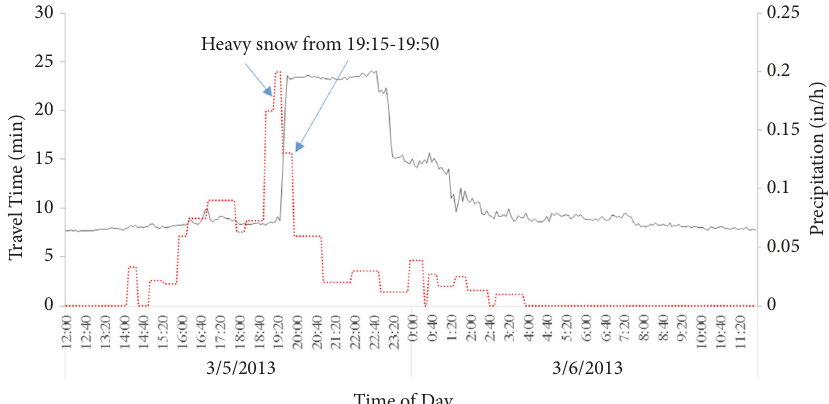
Figure 4: Travel time during severe snow